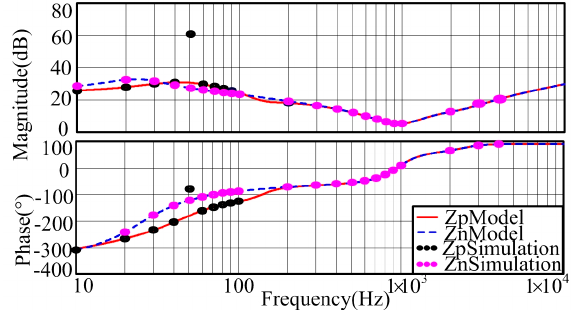
Figure 9. Impedance response with αβ -domain GC control.